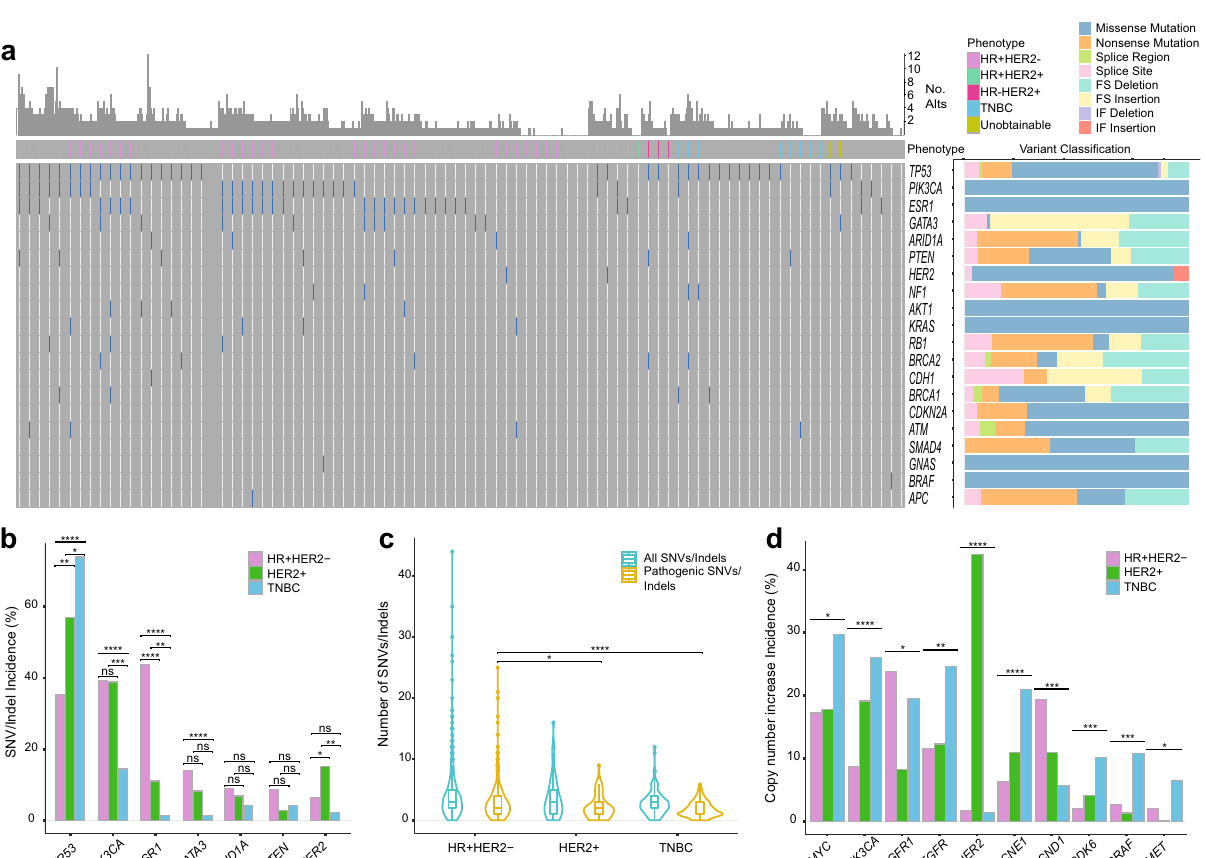
Fig. 1 Mutation pro fi le of advanced breast cancer determined by ctDNA sequencing. a Mutational pro fi le of advanced breast cancer determined by ctDNA targeted sequencing of 800 patients in the plasmaMATCH trial. Displayed are mutations and indels likely to be pathogenic ( “ Methods ” ), summarised by gene for each patient. Top bar refers to total counts of pathogenic mutations per patient. Right , variant classi fi cation of the alterations within each gene. FS, frameshift; IF, in-frame. b Breast cancer subtype association of the most frequently mutated genes within patients with known phenotype (HR + HER2- N = 515, HER2 + N = 72, TNBC N = 138). Comparison with false discovery corrected two-sided Fisher ’ s exact tests ( TP53 : HR + HER2- vs HER2 + q = 0.003, HR + HER2- vs TNBC q <0.0001, HER2 + vs TNBC q = 0.04; PIK3CA : HR + HER2- vs TNBC q < 0.0001, HER2 + vs TNBC q = 0.0008; ESR1 : HR + HER2- vs HER2 + q <0.0001, HR + HER2- vs TNBC q <0.0001, HER2 + vs TNBC q = 0.008; GATA3 : HR + HER2- vs TNBC q < 0.0001; HER2 : HR + HER2- vs HER2 + q = 0.05, HER2 + vs TNBC q = 0.005). ns, not signi fi cant. c Patient mutation frequency split by breast cancer subtype, overall and likely pathogenic mutations in patients with known phenotype (HR + HER2- N = 515, HER2 + N = 72, TNBC N = 138). Data are presented as a violin plot with inlayed boxplot, where the middle line is the median, the lower and upper hinges represent the 25 th and 75 th centiles respectively and the whiskers extend from the hinge to the smallest and largest value, respectively, no further than 1.5 x IQR (interquartile range) from the lower or upper hinge. Data outside of these ranges are plotted individually. Comparison of likely pathogenic mutations with false discovery corrected two-sided pairwise Kruskal-Wallis test, HR + HER2- vs HER2 + q = 0.03, HR + HER2- vs TNBC q < 0.0001. d Frequency of copy number increases in ctDNA split by breast cancer subtype in patients with known phenotype (HR + HER2- N = 515, HER2 + N = 72, TNBC N = 138). Comparison with false discovery corrected Chi-squared tests ( MYC q = 0.01, PIK3CA q < 0.0001, FGFR1 q = 0.01, EGFR q = 0.001, HER2 q < 0.0001, CCNE1 q < 0.0001, CCND1 q < 0.001, CDK6 q = 0.0003, BRAF q = 0.0002, MET q = 0.01). FS, frameshift; IF, TP53 in ctDNA ( q < 0.0001 and q = 0.0009, respectively, Fig. 2e). Mutations in BRAF were identi fi ed in ctDNA sequencing in 1.6% (8/515) HR + HER2- cancers, not previously described in tissue sequencing, with activating mutations (G466X, G469X, D594N) and no V600E mutations. Otherwise, the mutational pro fi le identi fi ed in ctDNA and tissue across different breast cancer subtypes was broadly similar (Fig. 2e). Microsatellite instability was identi fi ed in 1.1% of advanced breast cancers. Comparing ctDNA-derived mutations to a primary treatment- naive breast cancer tissue sequencing dataset (TCGA) 29 , substantial differences were observed (Supplementary Fig. 6) 11,13 . PIK3CA mutations were less common in metastatic HR + HER2- disease ( q < 0.0001), whilst ESR1 , AKT1 and alterations in the epigenetic regulator ARID1A were enriched ( q < 0.0001, q = 0.006 and q = 0.04, respectively, Supplementary Fig. 6) compared to